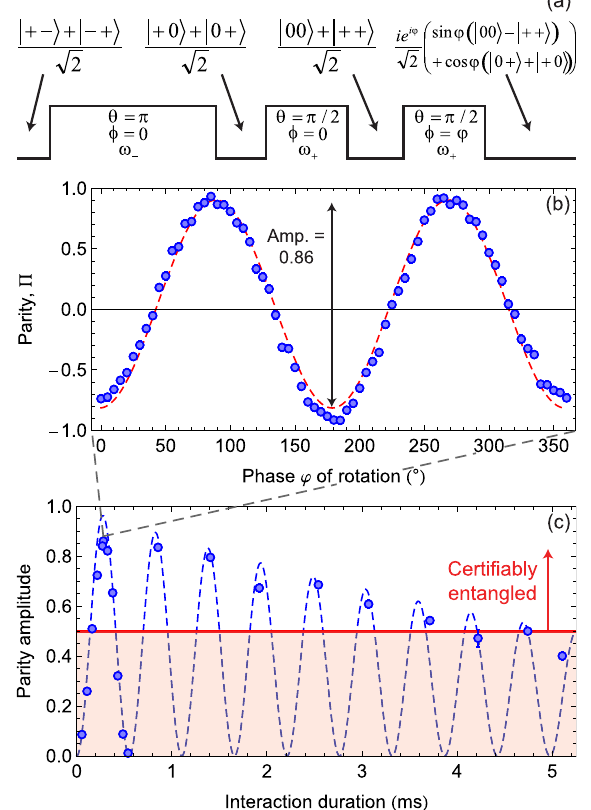
FIG. 3. (a) Illustration of the rotations performed before measuring the parity, where rotations by θ and φ are defined in Eq. (5). Also shown are the ideal initial state and the states produced after each step. (b) The parity of the final state oscillates as a function of the final pulse phase φ . Fitting the function C − A cos 2 φ þ B sin 2 φ (red dashed line) to the data results in an amplitude A ¼ 0 . 86 > 0 . 5 , demonstrating entanglement. (c) Am- plitude of the parity oscillation after various durations of the spin- spin interaction, showing the peak amplitude for each time ffiffiffi p ∼ ð 2 n þ 1 Þ = ð 2 2 J Þ . The data in (b) correspond to the high- 1 ; 2 est-contrast point in (c). The dashed line is a guide to the eye, suggesting the expected behavior of sinusoidal oscillations between a product state and an entangled state, along with decay due to decoherence at longer times. The chosen durations are not evenly spaced past 0.6 ms: for each point, the duration is chosen such that the population in j 00 i is at a local minimum, and drifts in the radial trap frequencies lead to small changes in J 1 ; 2